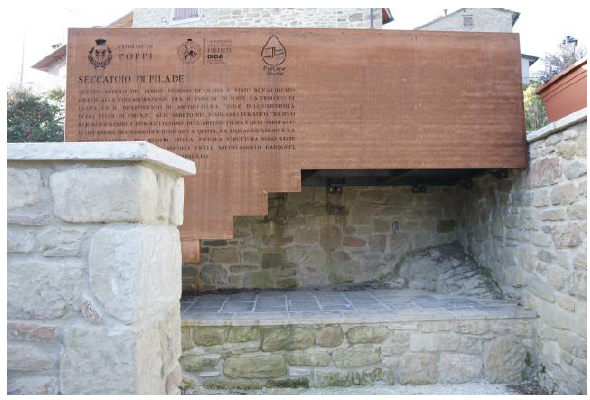
Figure 15. The finished small artifact saw other